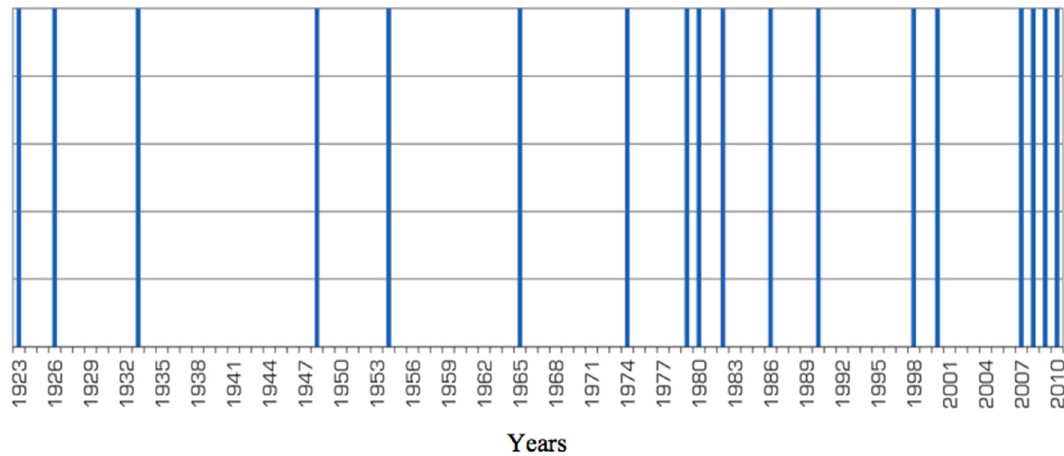
Figure 3. Occurrence of extensive floods in Slovenia [30].